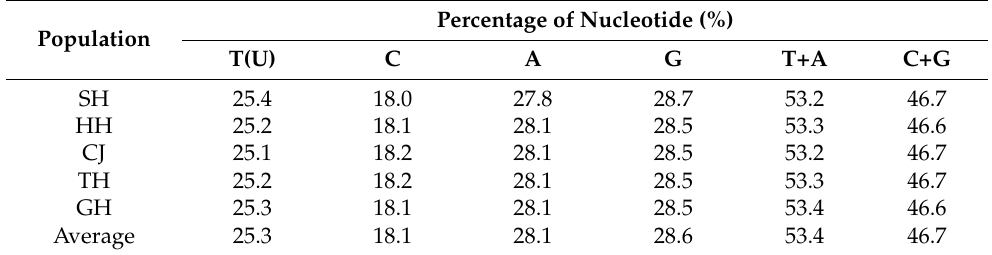
Table 2. Average base content of COI gene sequences of five populations of C. alburnus